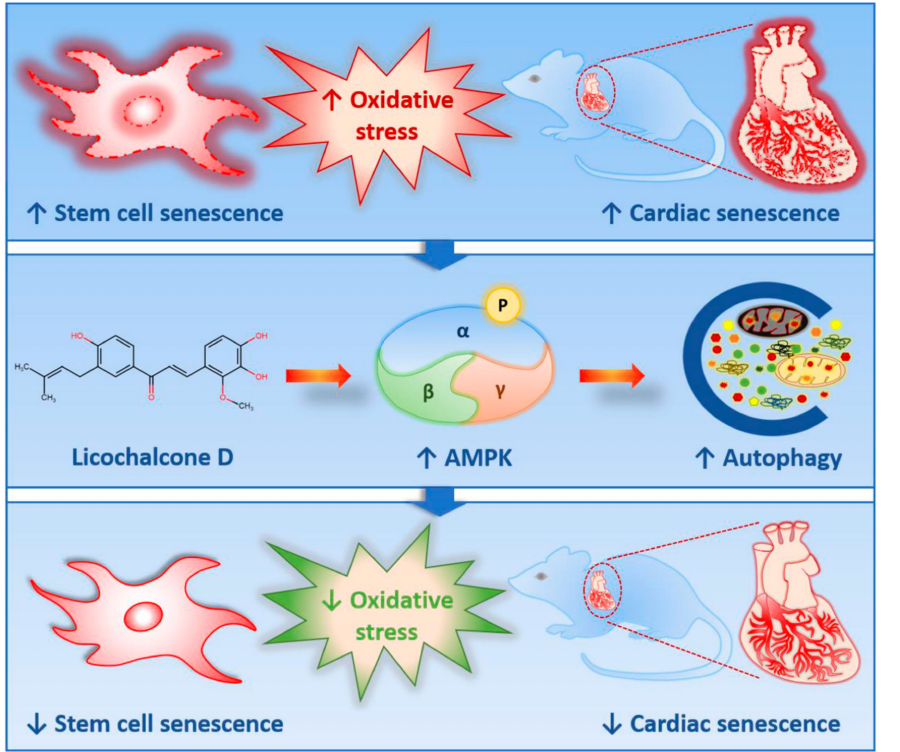
Figure 8. Lico D ameliorates oxidative stress induced senescence in stem cells and aging mice via